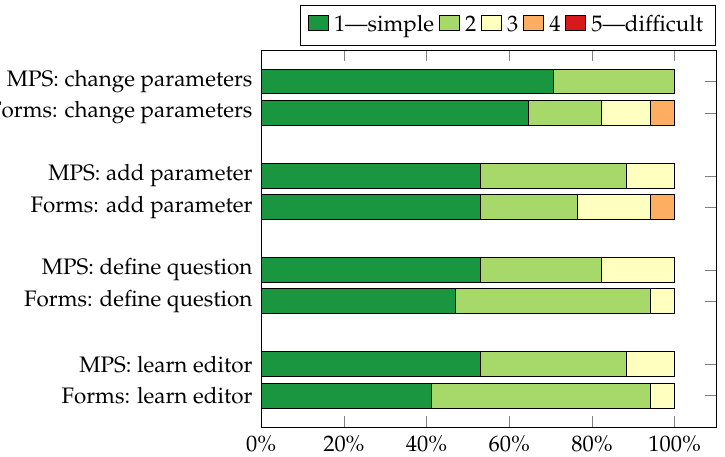
Figure 7. Survey results of the Xtext vs.Google Forms experiment.